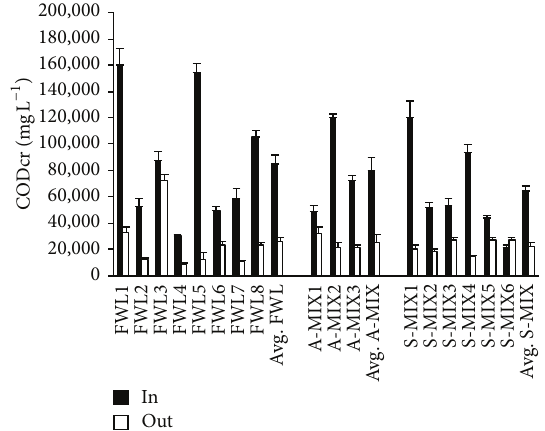
Figure 3: CODcr of each anaerobic digestion